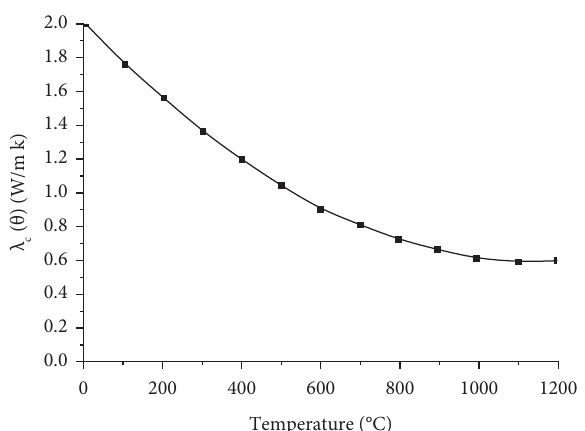
Figure 10: Concrete density variation with temperature [19].